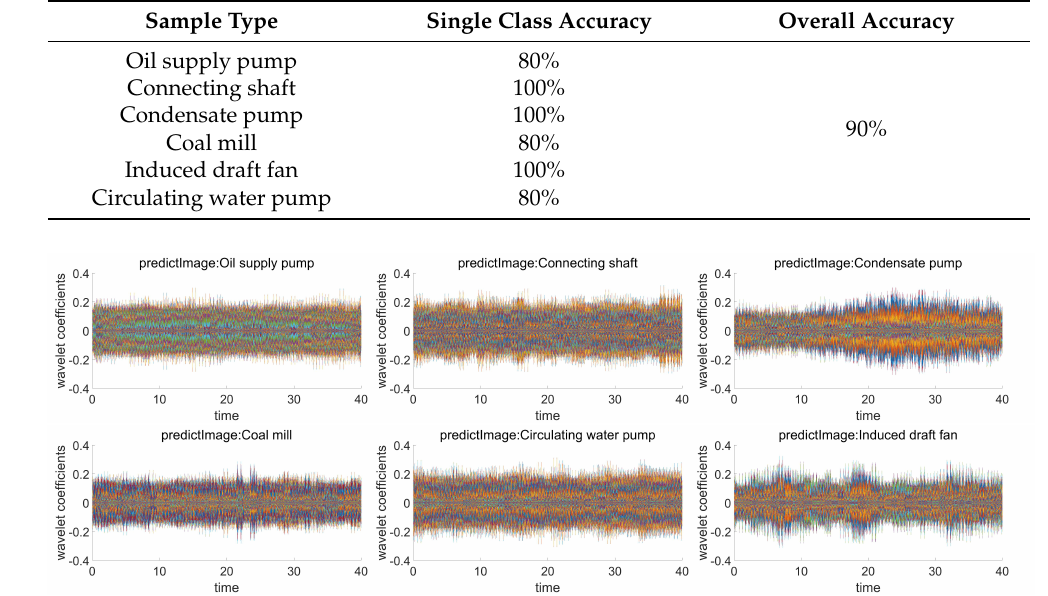
Figure 4. Original sound classification of equipment. The abscissa represents time, and the ordinate represents wavelet coefficients.